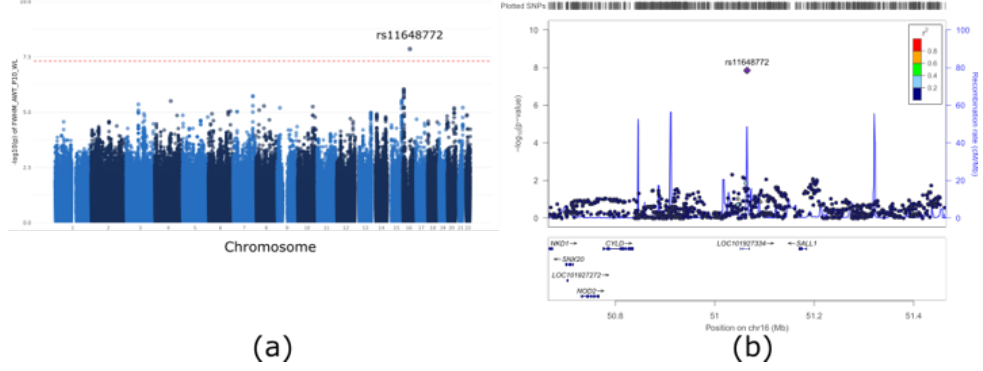
Figure 2. Meta-analysis results. ( a ) Manhattan plot of p values from the genome-wide association study (GWAS). One region on chromosome 16 met genome-wide significance ( p < 5 × 10 − 8 ) according to the meta-analysis of CODA and KUCOPD data. ( b ) The expanded Manhattan plot of the 800 kb region shows both genotyped and imputed single-nucleotide polymorphisms (SNPs). rs11648722, the most significant SNP, is indicated by the purple diamond, and other SNPs are coloured according to their r 2 values in relation to that of rs11648722. LOC101927334 ( LINC02127 ) and SALL1 are the closest located genes.